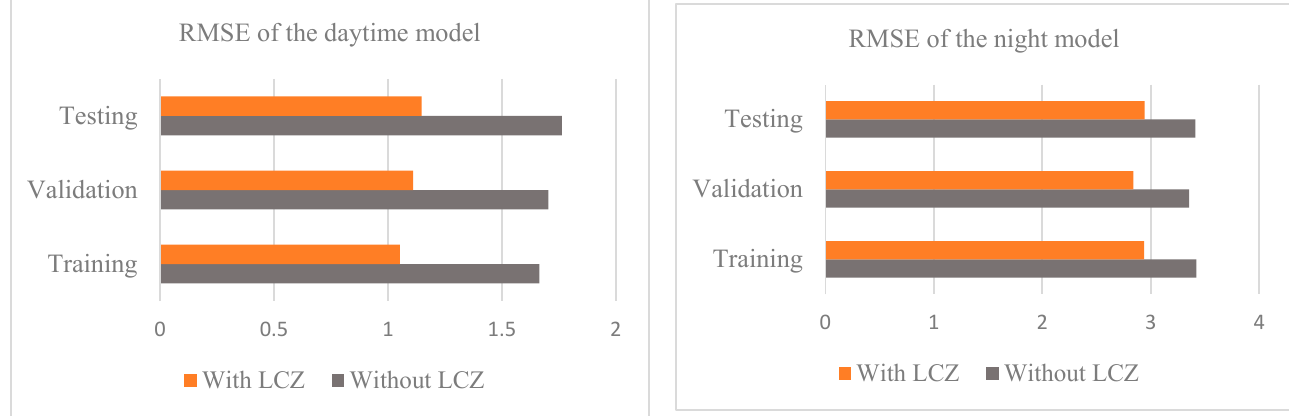
Figure 12. Comparison of model RMSE values.